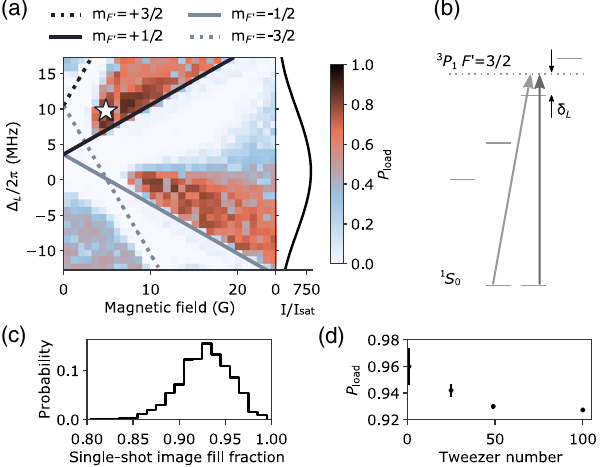
FIG. 2. Near-deterministic loading. (a) Loading efficiency ( P ) dependence on applied magnetic field and loading beams load detuning ( Δ ) from the free-space resonance. The star denotes the L parameters chosen for daily operation: magnetic field of 4.9 G = 2 π ¼ þ 9 . 76 MHz. The intensity of the loading beams and Δ L changes as a function of Δ , in the starred region corresponding L 0 . 138 mW = cm 2 is the saturation intensity , where I to 515 I sat sat ¼ of the 1 S 0 ↔ 3 P 1 transition. The resonance frequencies of the transitions to the m states are plotted as a function of the F 0 magnetic field. (b) Levels involved in the loading scheme for parameter space denoted with the star in (a). Accounting for tweezer light and magnetic shifts, the loading beams are blue 1 = 2 by δ 2 π × 2 . 8 MHz ( 15 . 6 Γ ). detuned from m F 0 ¼ þ L ¼ þ (c) Probability of obtaining a given fill fraction for a single-shot image. (d) Optimal average loading efficiency ( P ) as a load function of the tweezer array size. The error bars correspond to standard deviations of the binomial distributions given by the measured